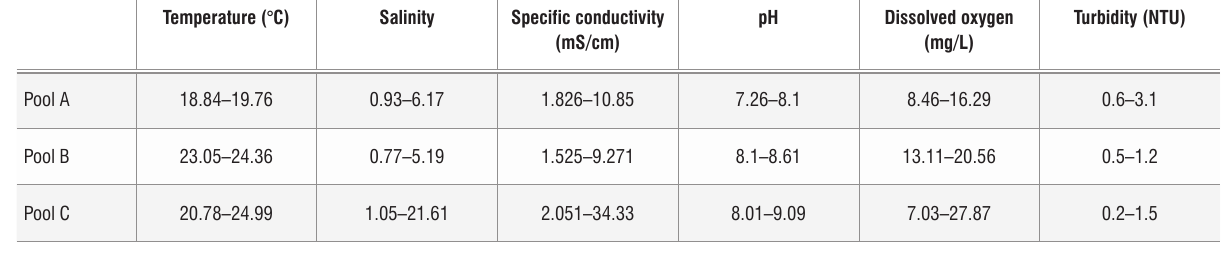
Table 1: Range of physico-chemical parameters in stromatolite pools measured during October 2013 Temperature (°C) Salinity Specific conductivity Pool